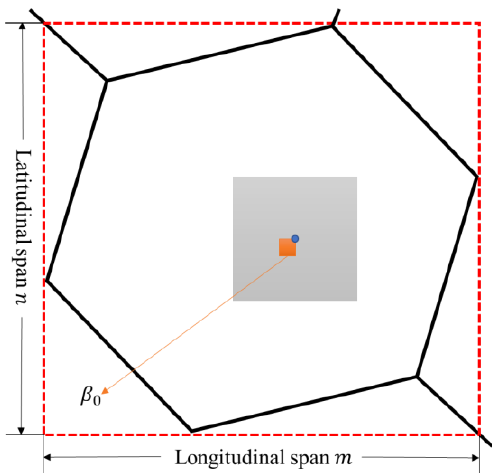
Figure 4. Location identification method of hexagonal equal area grid.